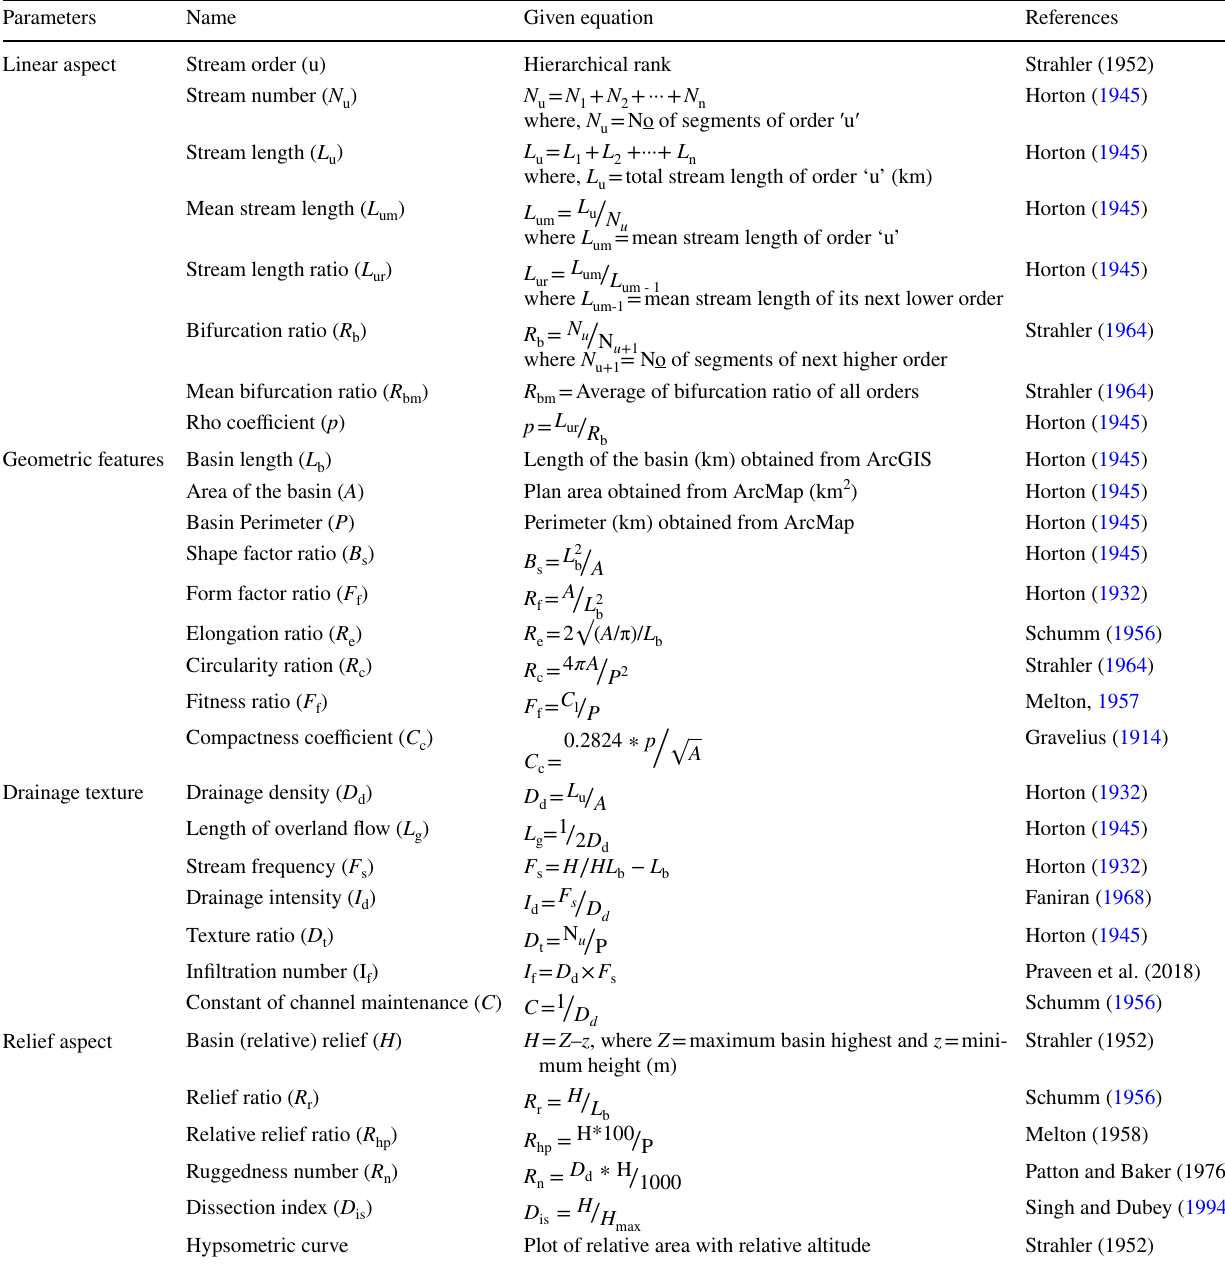
Table 1 Adopted mathematical equations to compute the morphometric parameters